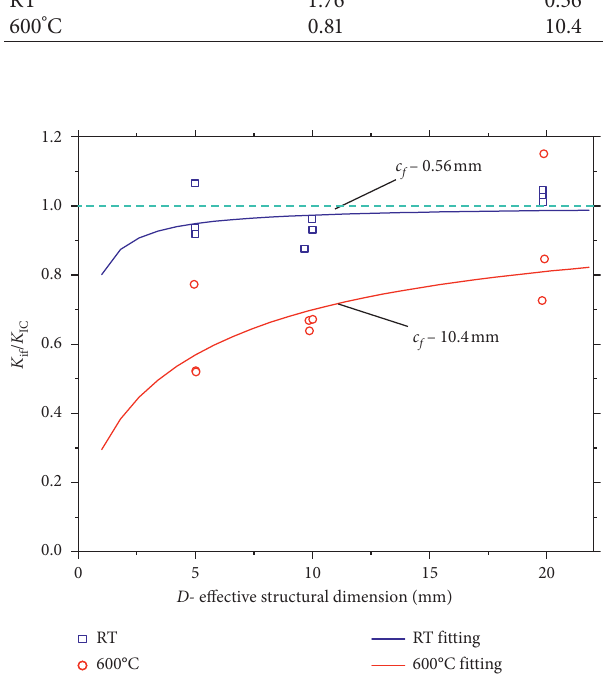
Figure 11: Variation of K if / K IC of granite with the effective structural dimension (blue indicates room temperature, and red indicates after treatment at 600 °